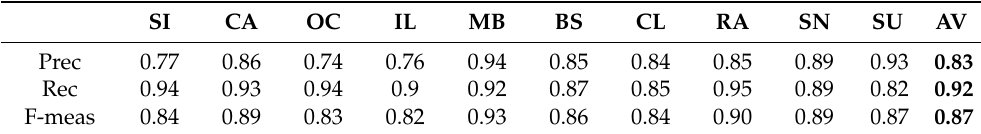
Figure 6. Precision vs. recall for the LASIESTA database. Table 3. Performance in precision, recall, and F-measure for the LASIESTA dataset. Categories are: simple sequences (SI), camouflage (CA), occlusions (OC), illumination changes (IL), modified background (MB), bootstrap (BS), cloudy conditions (CL), rainy conditions (RA), snowy conditions (SN), and sunny conditions (SU). Last column shows the Average